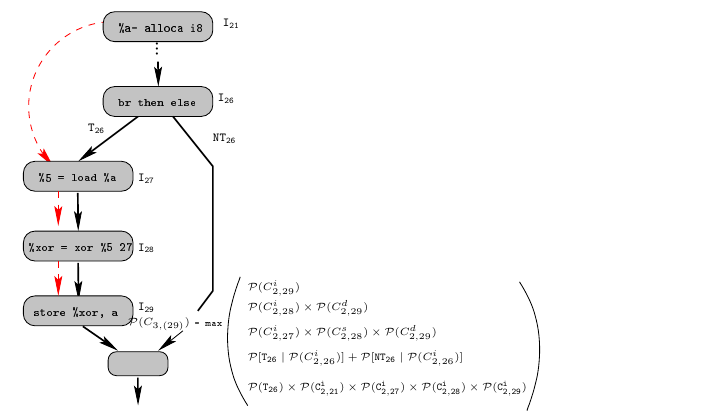
Figure 9: Fault propagation across the control flow instruction can corrupts the store instruction I 29 either through data-dependent sequence (marked in red) or by a fault in branch I 26